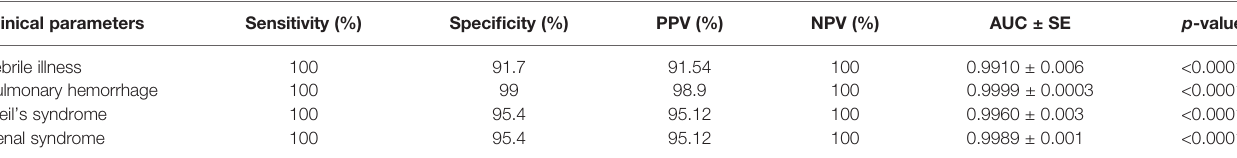
TABLE 4 | Receiver operating characteristic (ROC) analysis of macrophage migration inhibitory factor (MIF) as an early diagnostic marker for leptospirosis. Clinical parameters